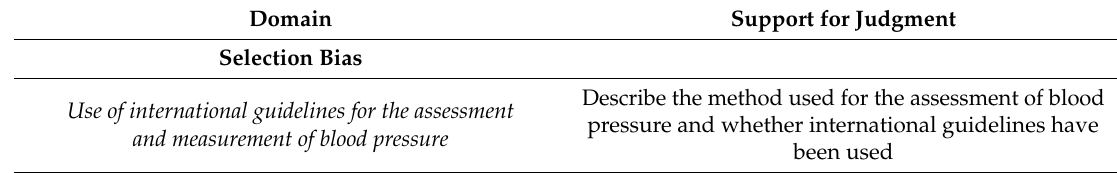
Table A1. The Modified Cochrane Collaboration’s tool for assessing the risk of